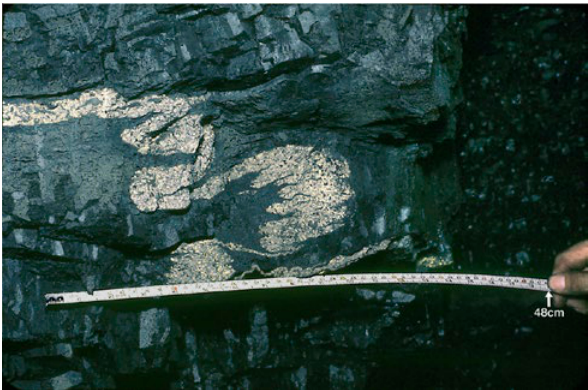
Figure 75. A ptygmatic sediment dike invades and transects the Greta coal seam apparently prior to its consolidation. The mate- rial of the dike is sandy with abundant clay, and close examination has shown that much of the rounded granular fine quartz is accre- tionary. Wet sediments trapped under gelatinous semi-consolidated coal apparently gave rise to this ptygmatic dike. Pelton Colliery, Newcastle, New South Wales.